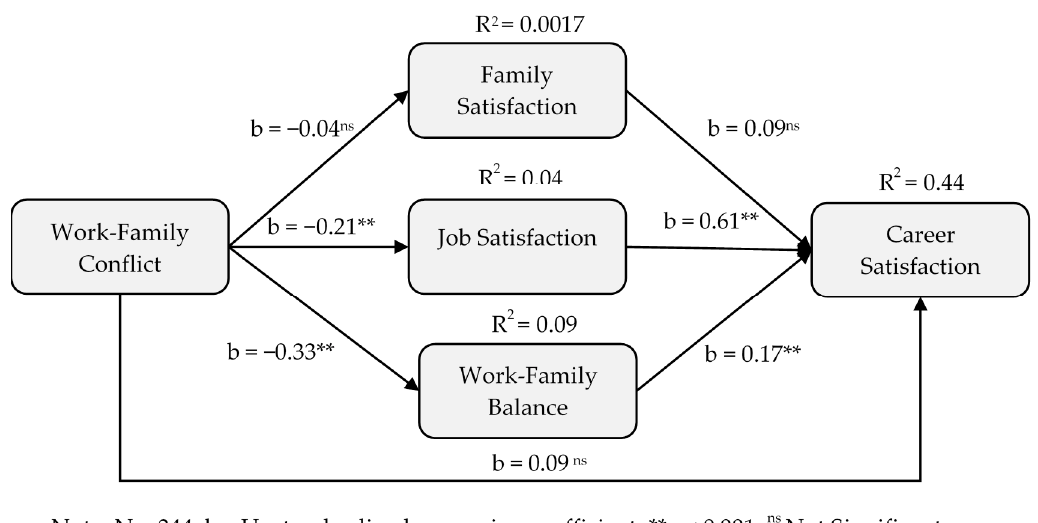
Figure 2. Mediational model on work-family conflict and career satisfaction.